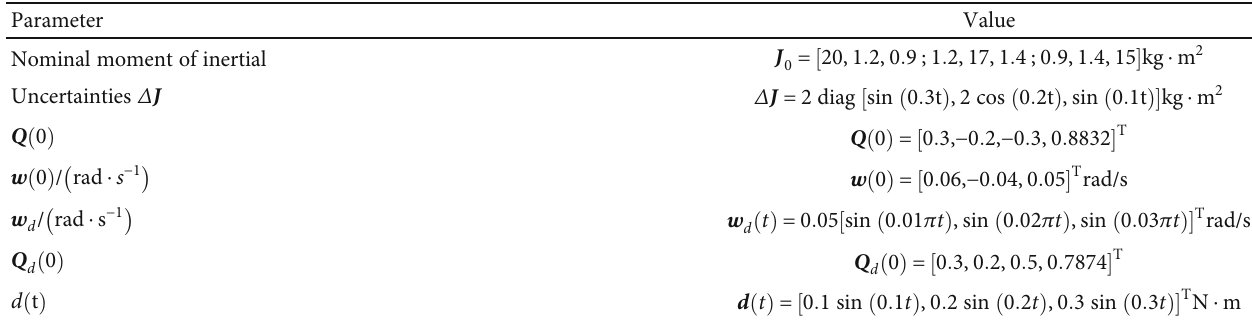
Table 1: The main parameters of spacecraft